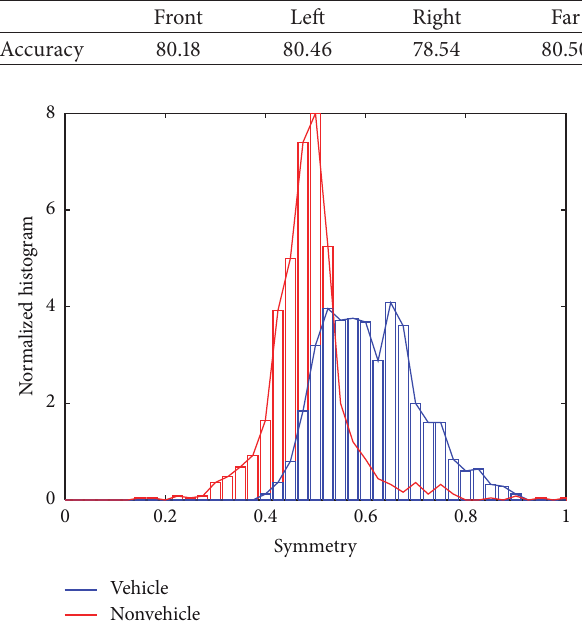
Figure 4: Normalized histogram of symmetry feature for vehicle (blue) and nonvehicle (red) classes in the front close/middle